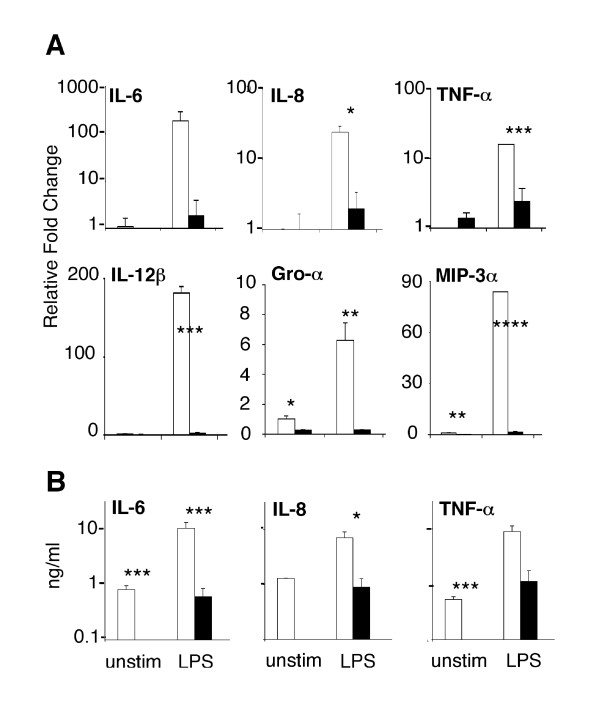
Expression of inflammatory cytokines and chemokines in IRAK4-deficient monocytes. A Expression of IL-6, IL-8, IL-12β, TNF-α, Gro-α/CXCL1 and MIP-3α/CCL20 in the healthy control pooled monocytes (white bars) and in both biological replicates of the patient's monocytes (black bars) were evaluated, in duplicate, by qPCR following a 4 hr incubation in the absence or presence of LPS (X-axis). B IL-6, IL-8 and TNF-α were also measured in the tissue culture supernatant of stimulated PBMC by multiplex cytokine bead immunoassays. The Y-axis represents fold change (log scale) in gene expression relative to unstimulated control monocytes (qPCR) or pg/ml of protein determined by the cytokine assay. Differences in expression or protein secretion were determined to be statistically significant by Student's two tailed T-test with a value of p < 0.15 (*), p < 0.1 (**), p < 0.05 (***) and p < 0.003 (****).